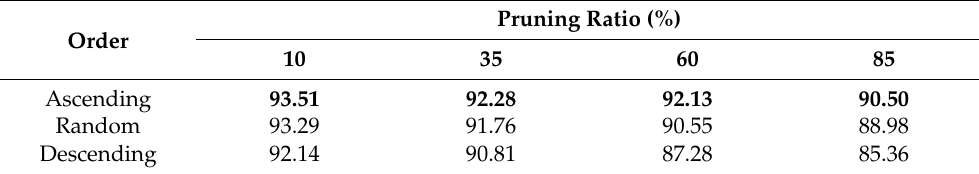
Table 3. Verification experiment results regarding the validity of the filter selection criteria.